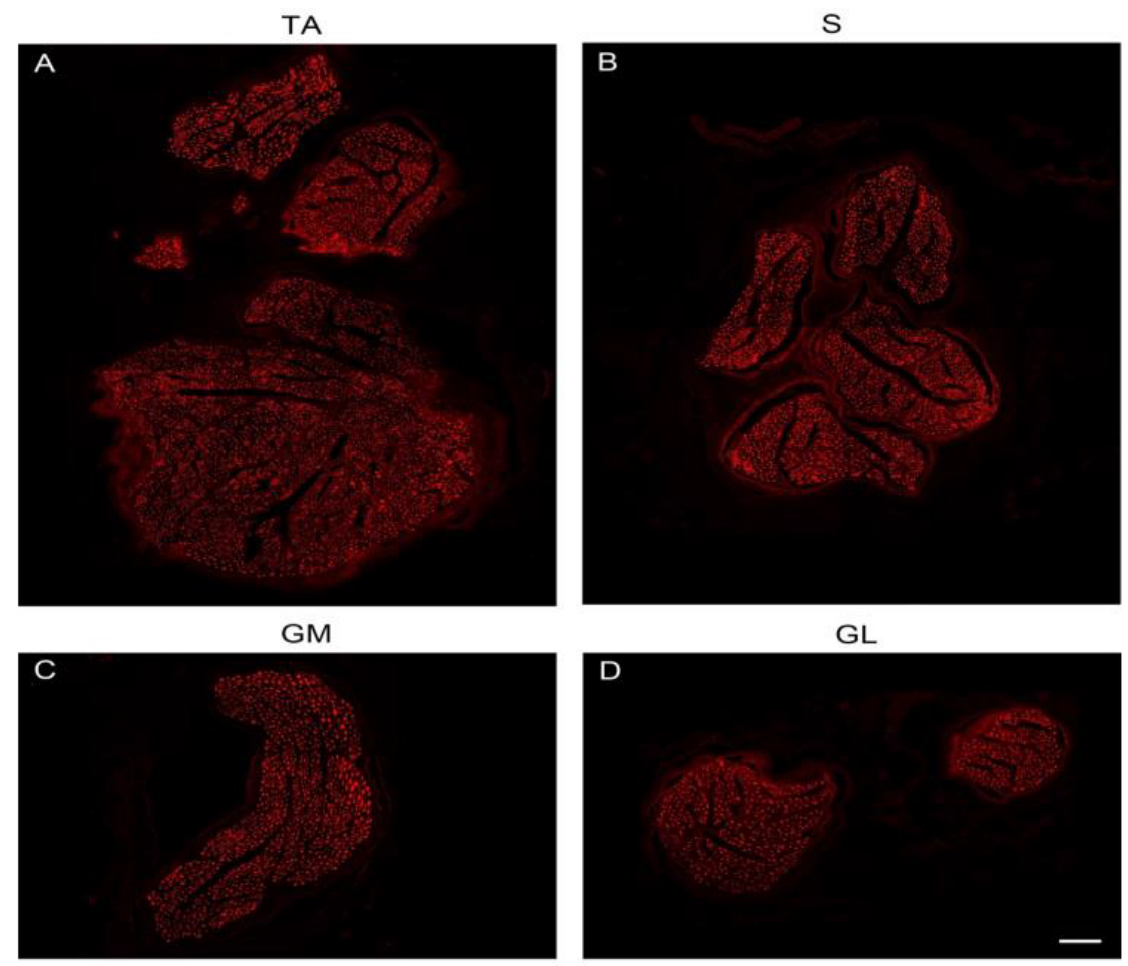
Figure 2. CLSM image, showing the four nerves of the lower extremity in NF staining. Scale bar, 100 µm.